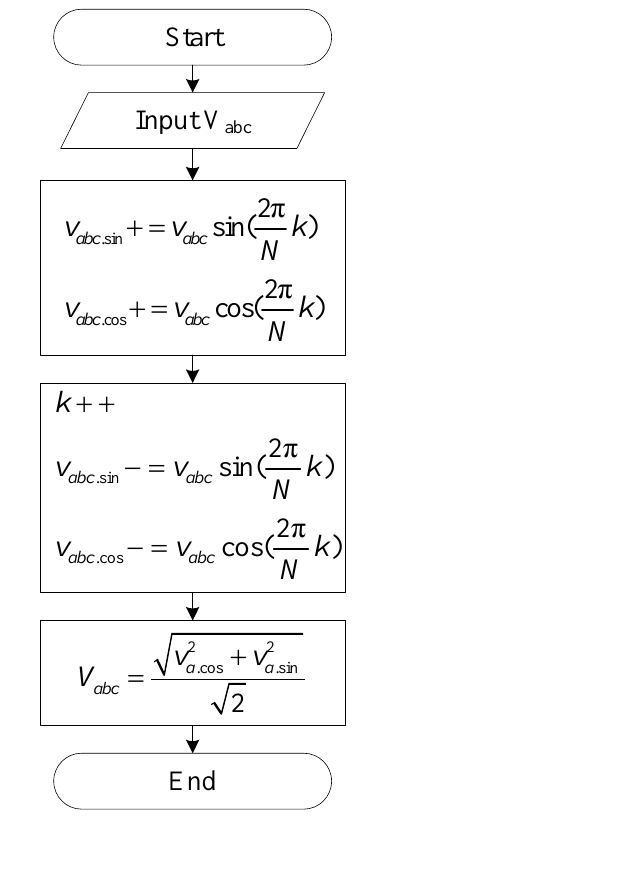
Figure 3. Flowchart of the conventional